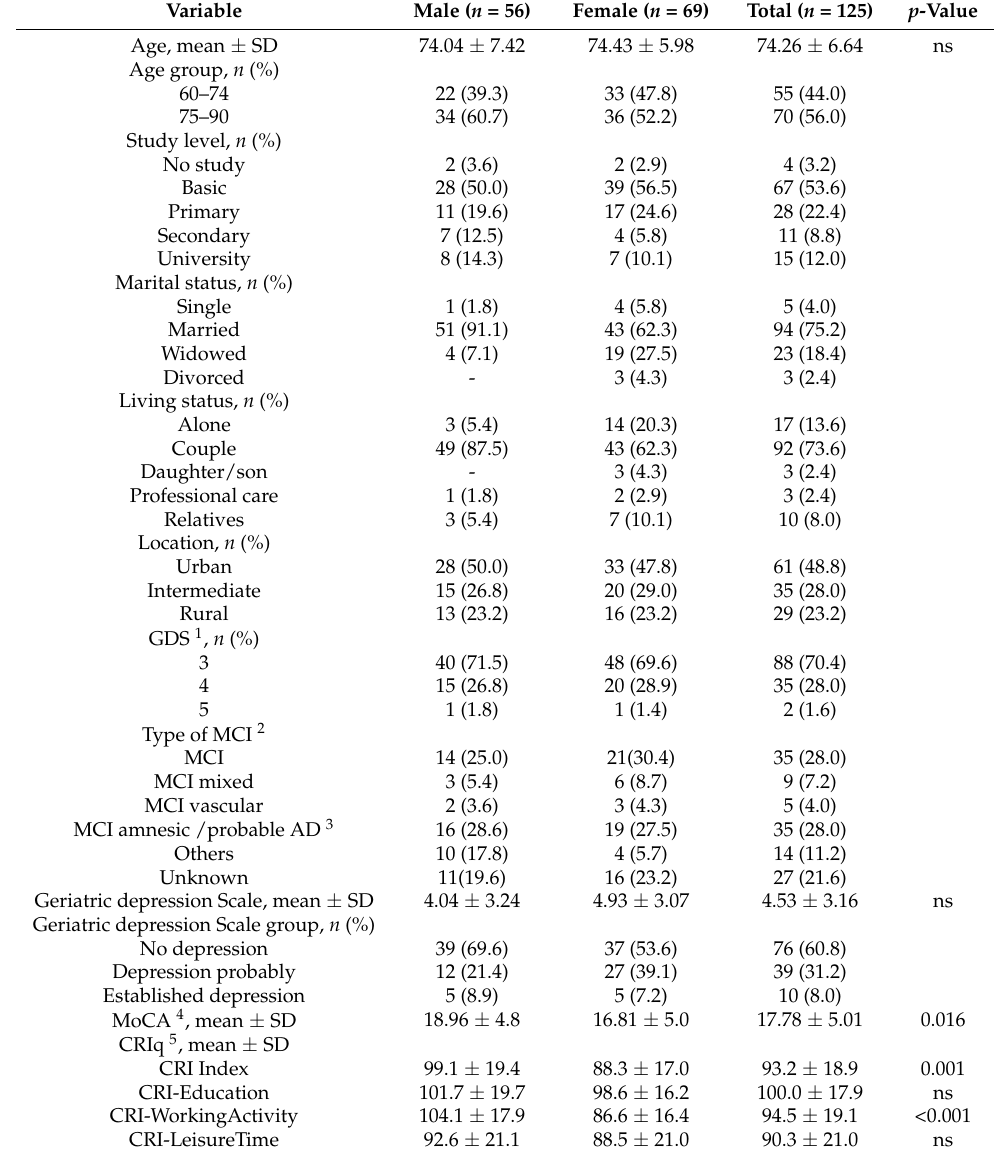
Table 1. Demographic and clinical characteristics.